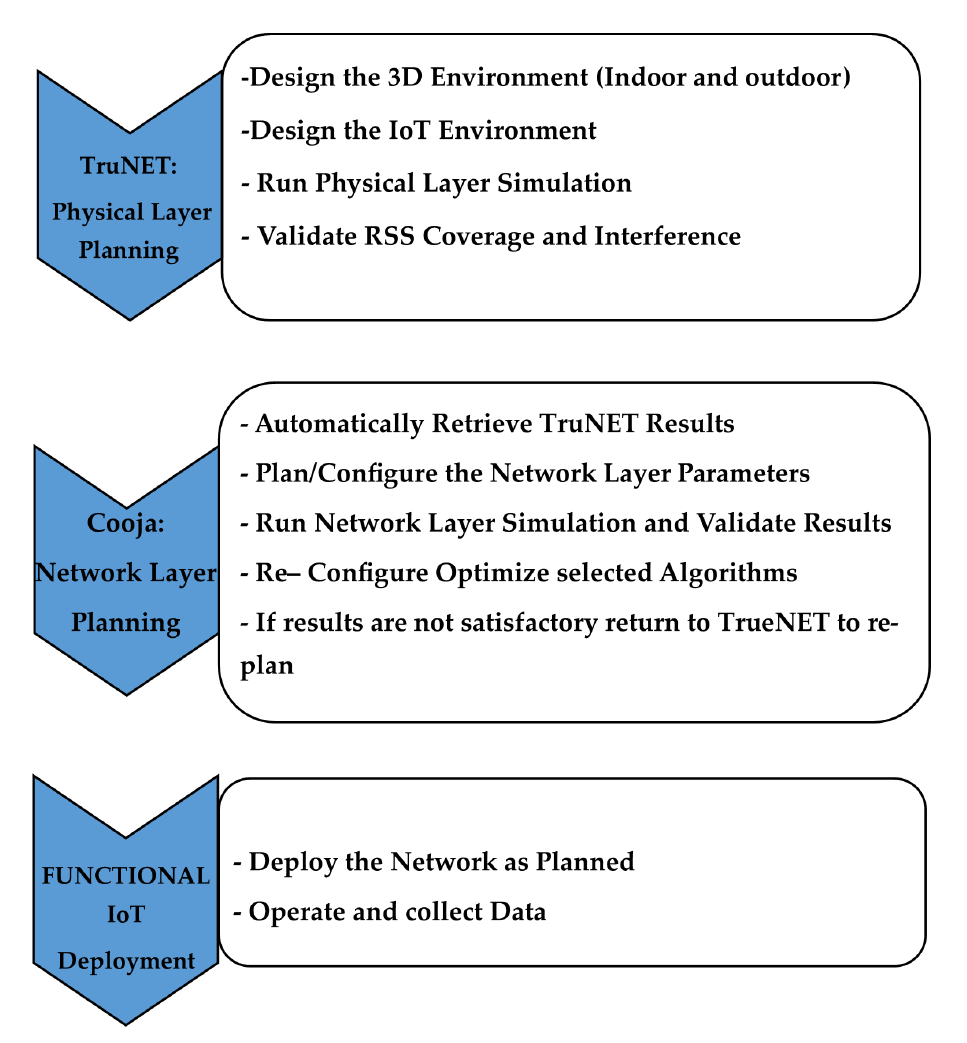
Figure 1. TruNET-Cooja interconnection: proposed methodology